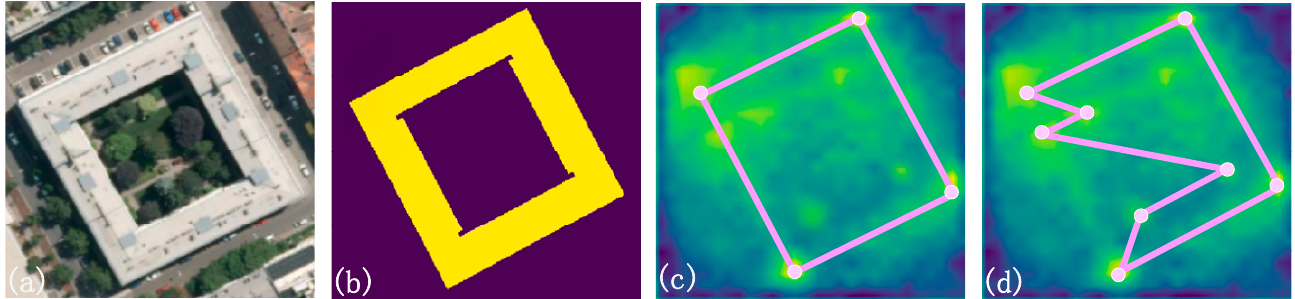
Figure 1. Buildings in the form of quadrangles in aerial images: ( a ) Austin; ( b ) Vienna.